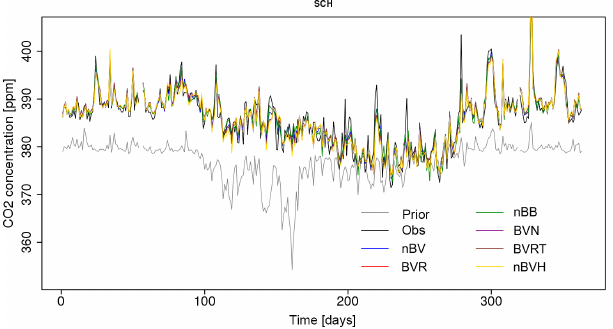
Figure 1. Daily nighttime (23:00–04:00UTC) averages for prior, true and posterior CO 2 dry mole fraction time series for the Schauinsland site for the real-data inversion. Time starts at 1 Jan- uary 2007.